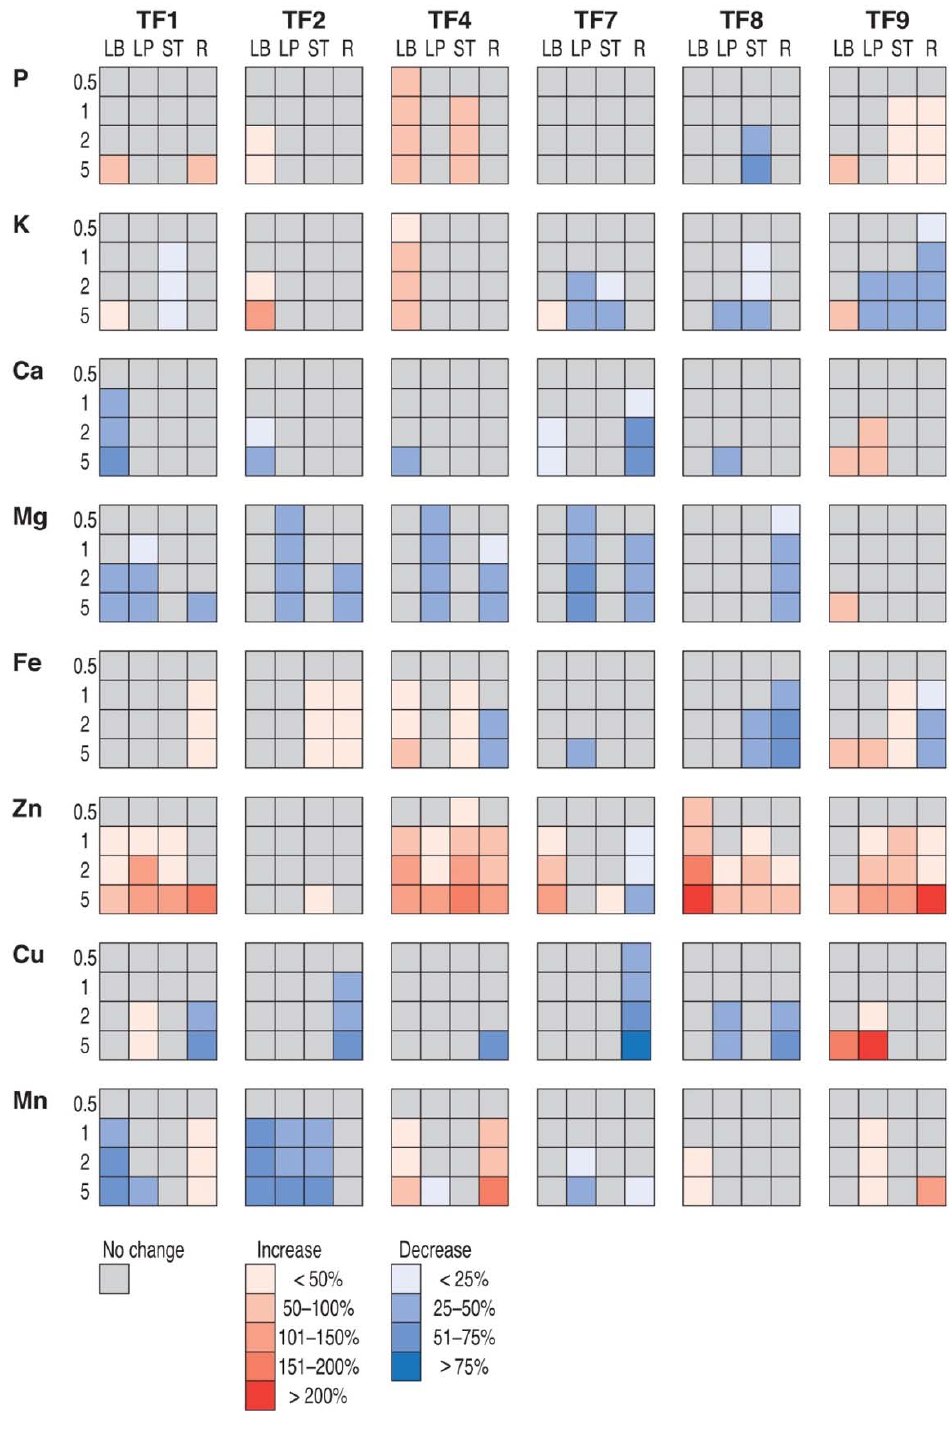
Figure 10. Relative effect of increasing substrate salinity on mineral element concentrations in leaf blades (LB), leaf petioles (LP), stolons (ST) and roots (R) of Trifolium fragiferum plants of different accessions. Numbers on the left side indicate added Na+ concentration (g L − 1 ). Only statistically significant effects are taken into account.